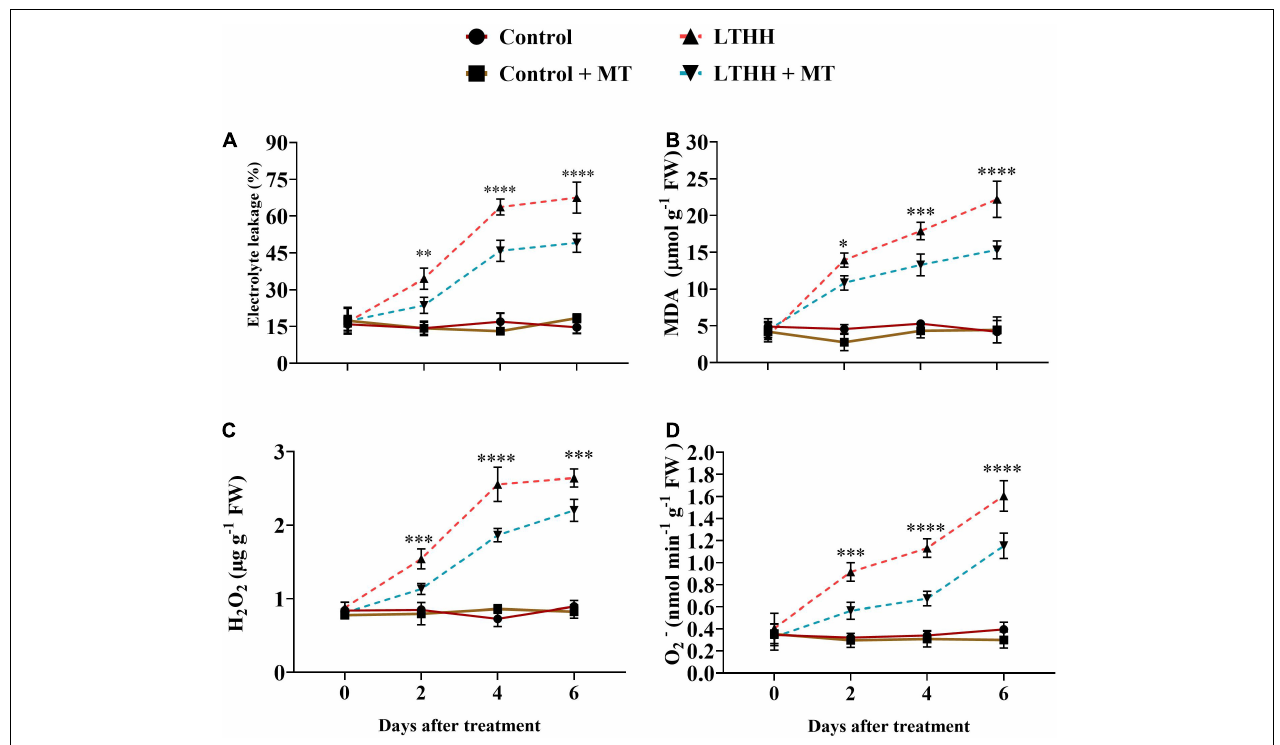
FIGURE 8 | Effect of exogenous melatonin on electrolyte leakage (A) , malondialdehyde (B) , hydrogen peroxide (C) , and superoxide anion (D) content of cucumber seedling under low-temperature and high-humidity stress. Control (25/18 ◦ C); Control + MT (200 µ M melatonin, 25/18 ◦ C); LTHH (15/10 ◦ C, 95%); LTHH + MT (200 µ M melatonin, 15/10 ◦ C, 95%). Results were presented as means ± SD ( n = 3), significance values were presented as: * P < 0.05; ** P < 0.01; *** P < 0.001; **** P < 0.0001; while non-significant (ns) ( P >